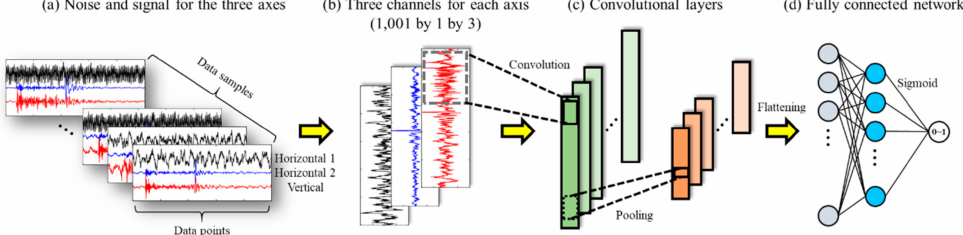
Figure 8. Schematic of CNN applied to seismic data with convolutional and fully connected layers for classification of noise and signal. ( a ) Training data of noise and signal from the three axes: the horizontal 1, 2, and vertical direction; ( b ) 1001 data points from each direction through the three channels as input data; ( c ) convolution and pooling layers for feature extraction; ( d ) the end of the neural network with fully connected layer and sigmoid to output between 0 and 1, indicating probability for